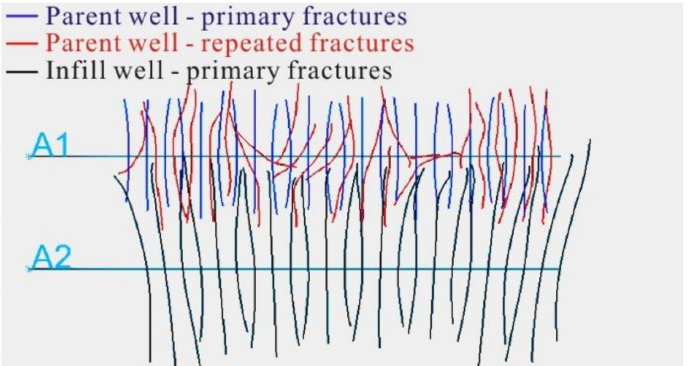
Figure 13. Fractures morphology of parent well and infill well after 4-year production (no water